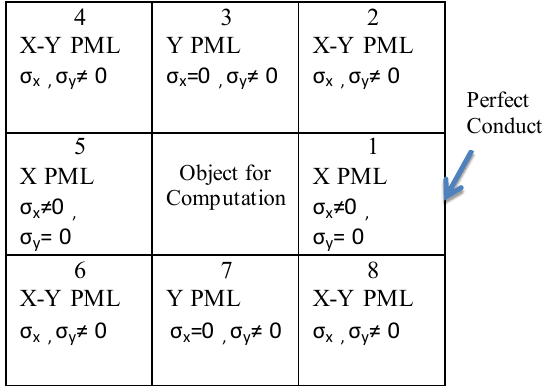
Figure 2: Layout of Perfectly Matched Layer Further in FDTD discretization of computational domain poses error due to truncation. Staircase approximation also contributes error accumulation at each time step for surface with sharp and fine edges [9]. Also reflection error increases with increase in time step affecting accuracy of